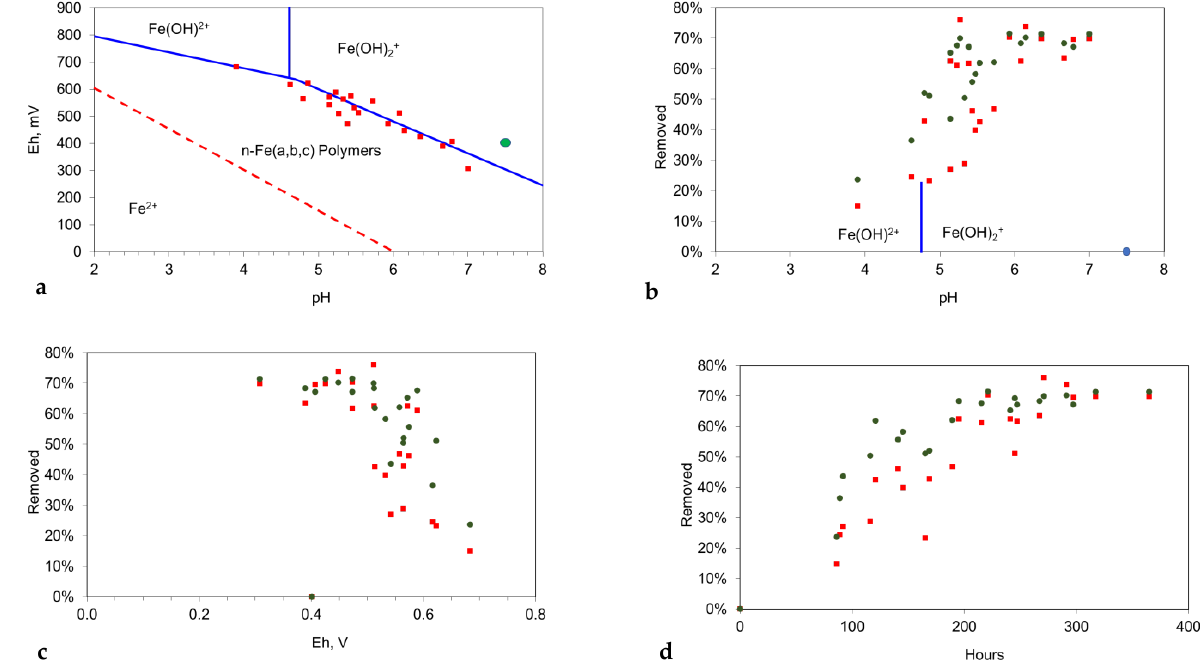
Figure 21. Example batch flow analysis for a n-Fe@Ca@Zn@gallic acid polymer, polymer composition: Trial 6, Table 2. Feedwater = seawater (15.83 g Cl - L − 1 ; 10.27 g Na + L − 1 ). Reactor size = 240 L. ( a ), =pH versus Eh; ( b ) pH versus proportion of ions removed; ( c ) = Eh versus proportion of ion removed; ( d ) cumulative reaction time, hours, versus proportion of the ions removed; blue dot = feed water; In ( b – d ) the red dots are Cl - ions; the green dots are Na +